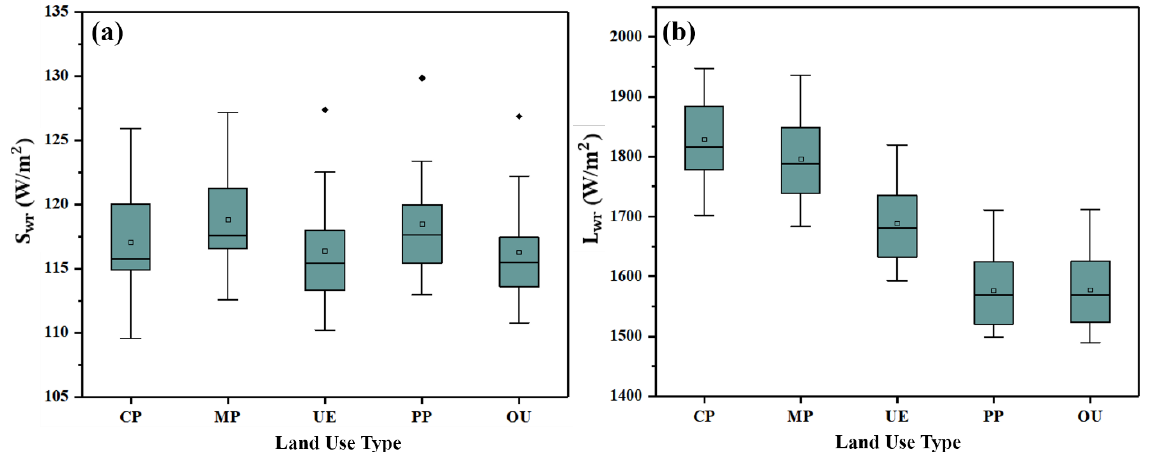
Figure 5. Statistical values of ( a ) net shortwave radiation ( S wr ) and ( b ) net long-wave radiation ( L wr ) based on five land types in the Huang-Huai-Hai River Basin from 2000 to 2015.